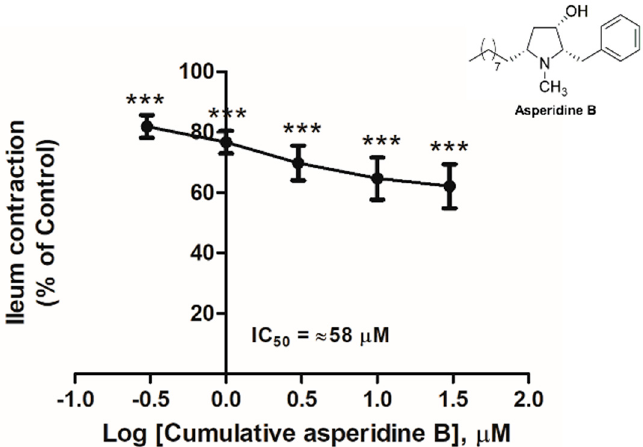
Figure 1. Antispasmodic effect of asperidine B on rat ileal contractions induced by KCl (80 mM, n = 6). *** p < 0.001 versus control.